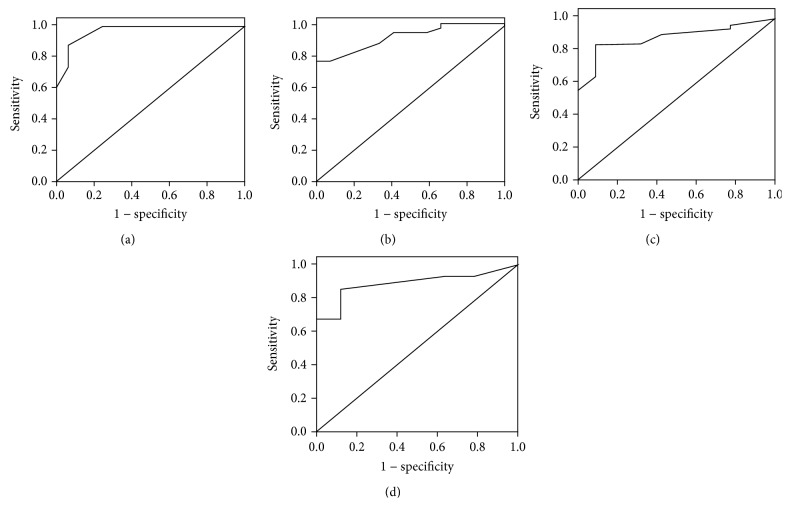
(a) A cut-off value of TCTT of 48.0 h predicts inadequate bowel preparation with 95.7% sensitivity and 85.4% specificity (AUROC = 0.969). (b) A cut-off value of RTT of 15.5 h predicts inadequate right colon preparation with 75.0% sensitivity and 85.7% specificity (AUROC = 0.866). (c) A cut-off value of LTT of 17.5 h predicts inadequate left colon preparation with 77.8% sensitivity and 75.0% specificity (AUROC = 0.818). (d) A cut-off value of RSTT of 19.0 h predicts inadequate rectal sigmoid colon preparation with 70.6% sensitivity and 91.9% specificity (AUROC = 0.893).